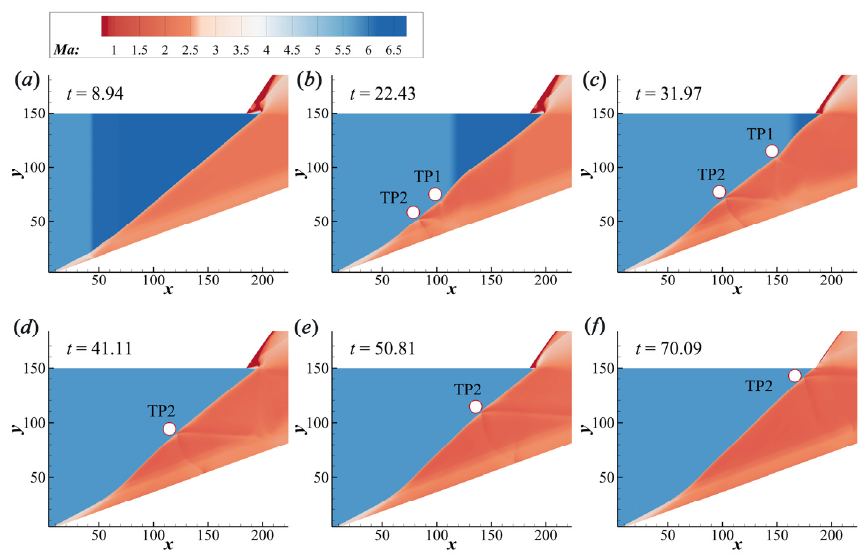
Figure 7. Velocity contours of ODW at different instants when M 0 decreases from 6.0 to 5.5. ( a ) t = 8.94, ( b ) t = 22.43, ( c ) t = 31.97, ( d ) t = 41.11, ( e ) t = 50.81, ( f ) t =